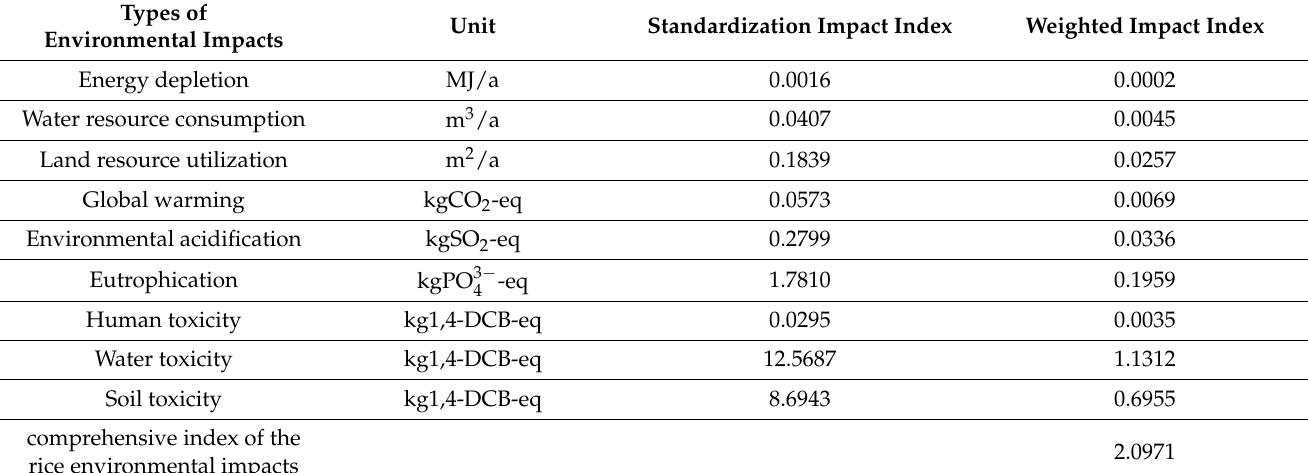
Table 5. Standardized and weighted analysis of the potential environmental impacts throughout the rice life cycle.